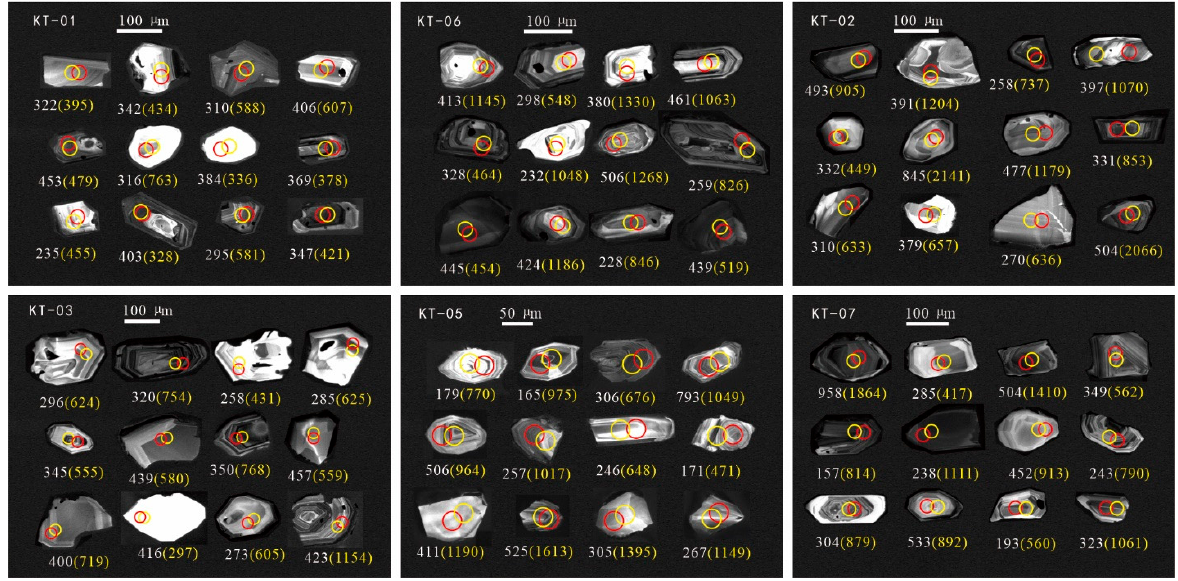
Figure 7. Representative detrital zircon micro-region CL image and age data (Ma). The white data is U-Pb age, and the yellow data is Hf two-stage model age. The red and yellow circles are laser ablation positions.